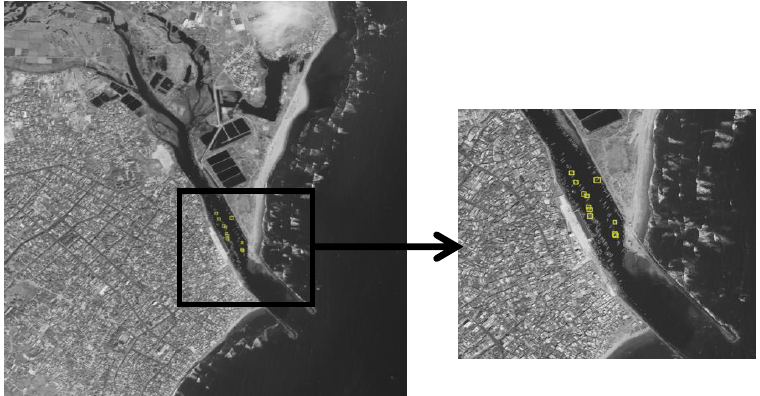
Figure 11. The detection performance for ships with the original Yolov5 in the original satellite image.